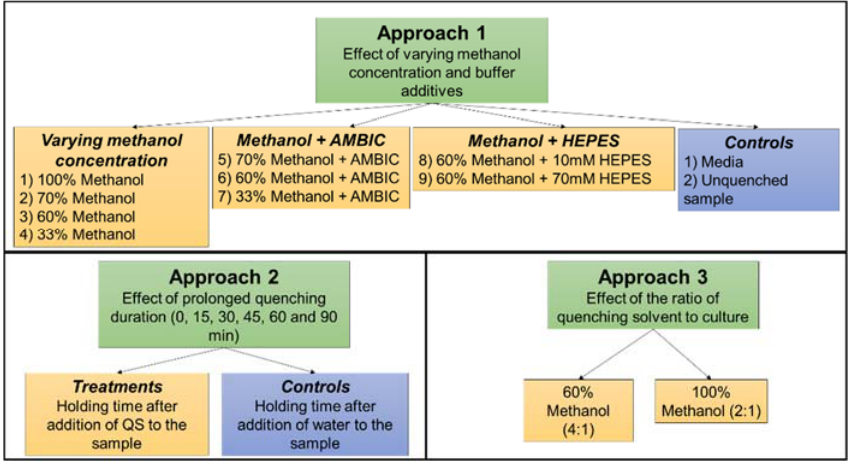
Figure 1. Experimental design and general workflow adopted for the evaluation and optimisation of quenching protocols for Chlamydomonas reinhardtii .